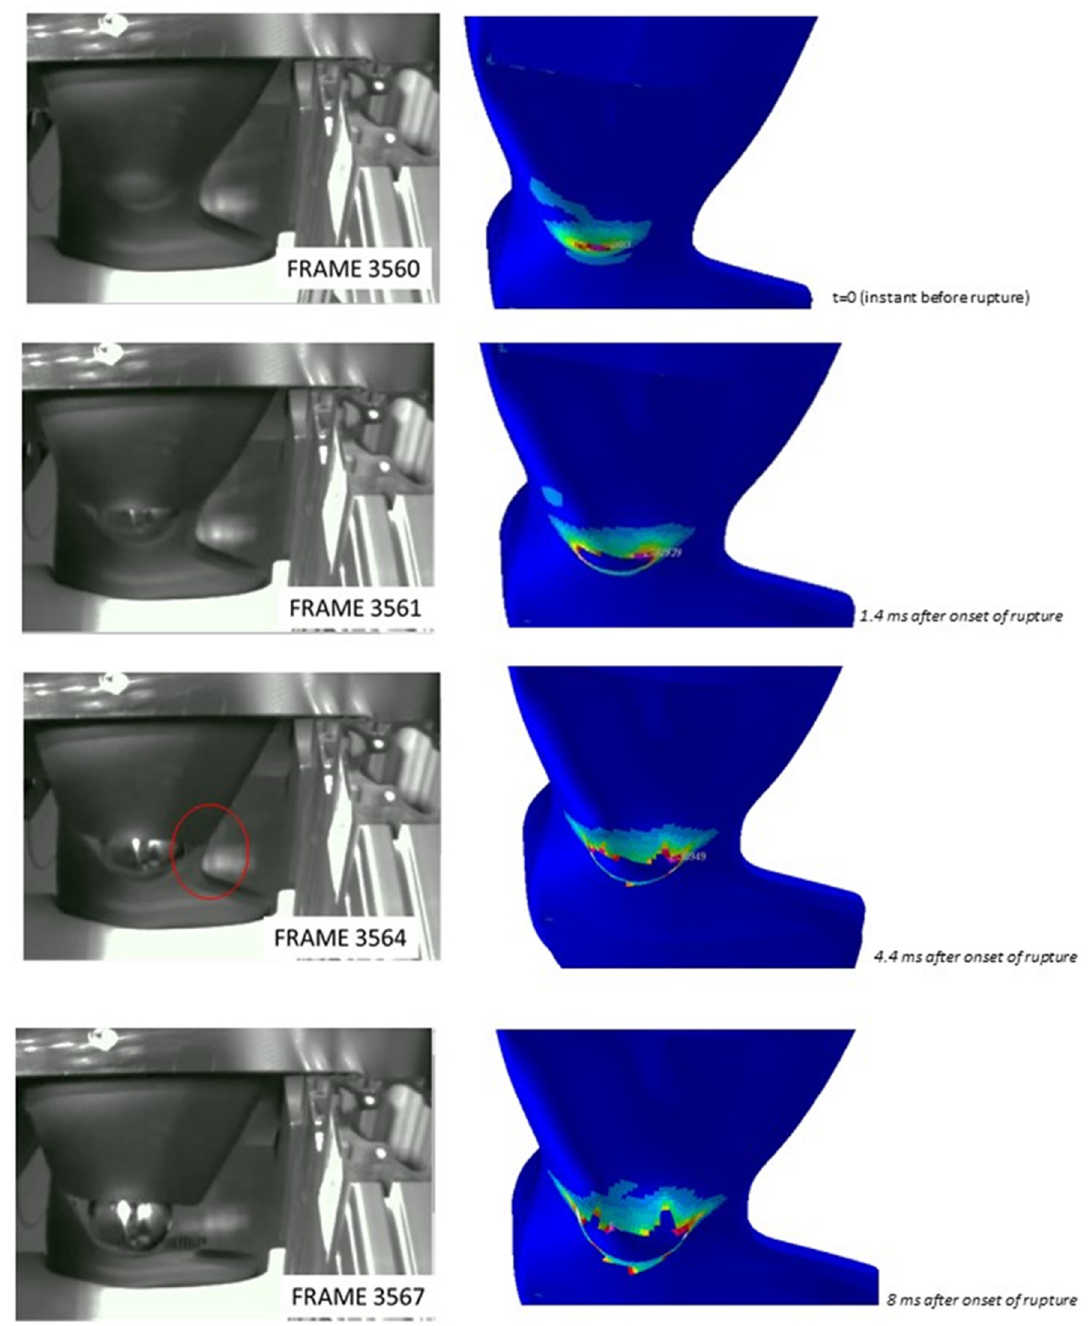
Figure 10. Comparison of fracture modes predicted by simulations ( right ) and observed experimen- tally ( left ) at different time instants during the impact sequence. Images refer to the 65 mm diameter impactor, impact speed of 4 m/s, and part thickness of 2.4 mm. Pictures from the experimental test provided by SMP GmbH, Bötzingen, Germany.